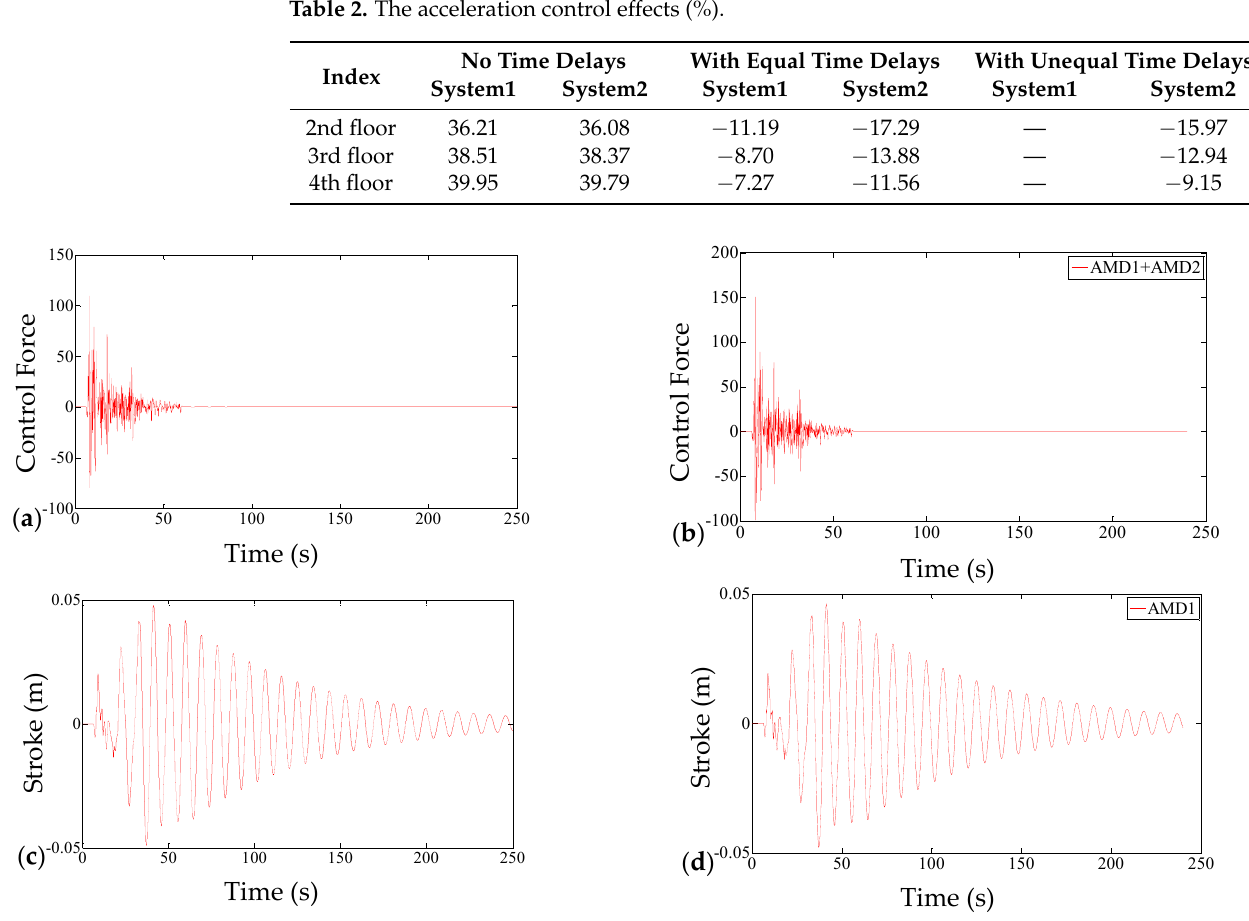
Figure 3. The AMD parameters of the systems without time delays, ( a ) the forces of System1, ( b ) the total forces of System2, ( c ) the strokes of System1, ( d ) the strokes to AMD1 of System2.